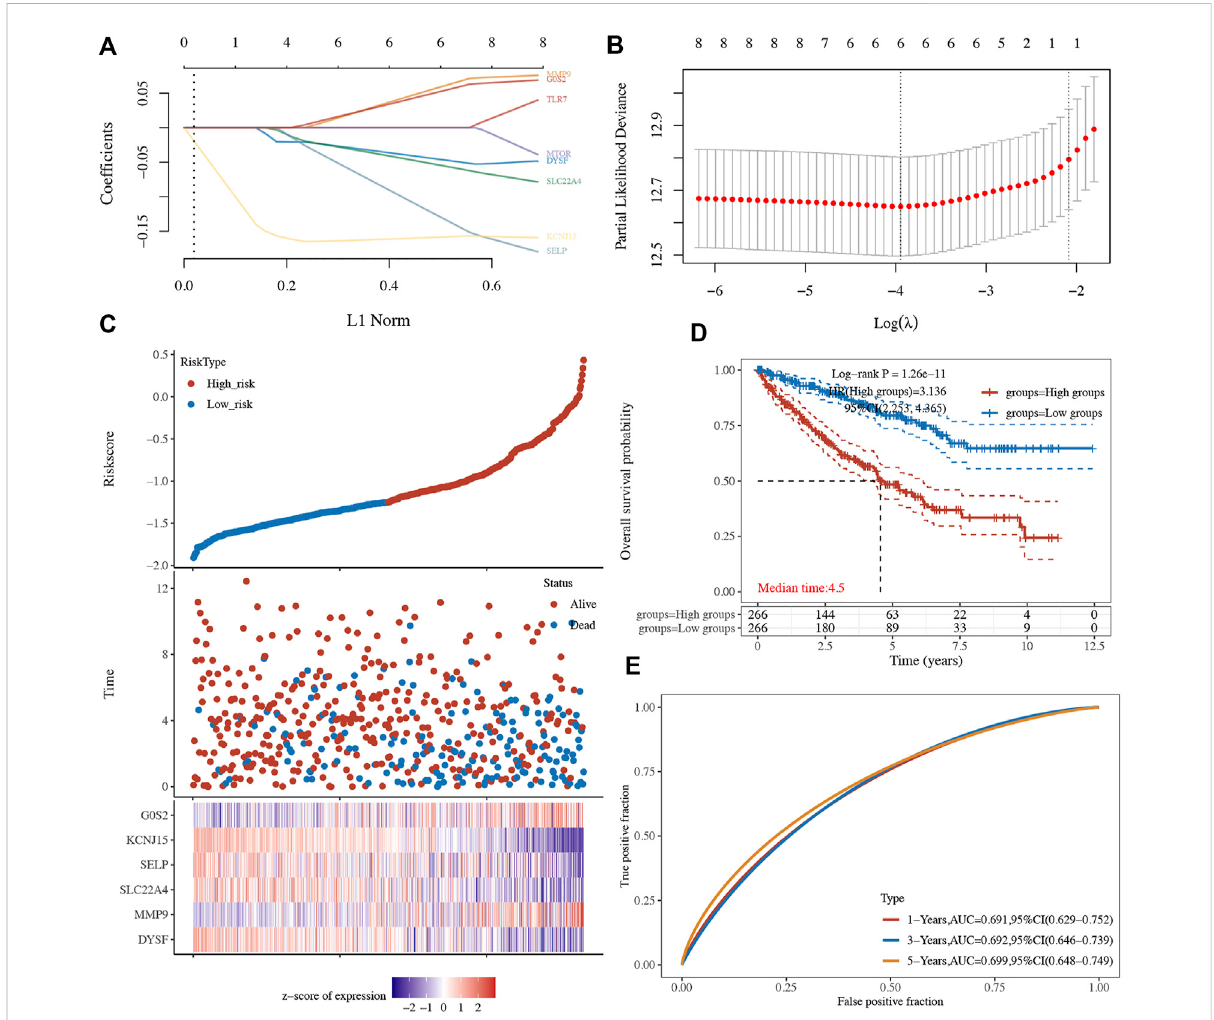
FIGURE 7 Prognostic signature in ccRCC based on NET-related genes in TCGA dataset. (A – B) The coef fi cient and partial likelihood deviance of the prognostic signature. (C) Riskscore distribution, patients ’ survival status, and gene expression pro fi le of the prognostic signature. (D) ccRCC patients in the high-risk group had a poor OS rate compared to that in the low-risk group. (E) AUCs of 1-year, 3-year, and 5-year ROC curves were 0.691, 0.692, and 0.699, respectively. NETs, neutrophil extracellular traps; ccRCC, clear cell renal cell